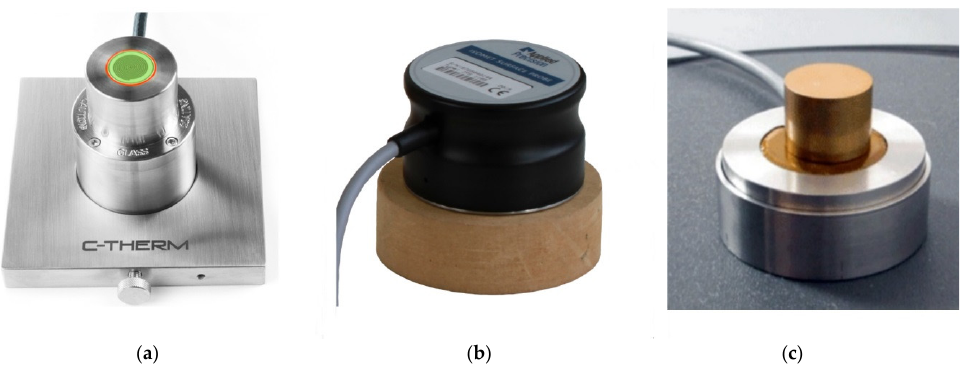
Figure 5. Various types of surface transient probes. The specimen or probe is large enough to ensure good contact. ( a ) Modified Transient Plane Source (MTPS) Sensor for TCi Thermal Conductivity Analyser [61]; ( b ) Surface probe for Isomet portable heat transfer analyser [45]; ( c ) Sensor for Hot Disk TPS Thermal Conductivity Instrument [60].